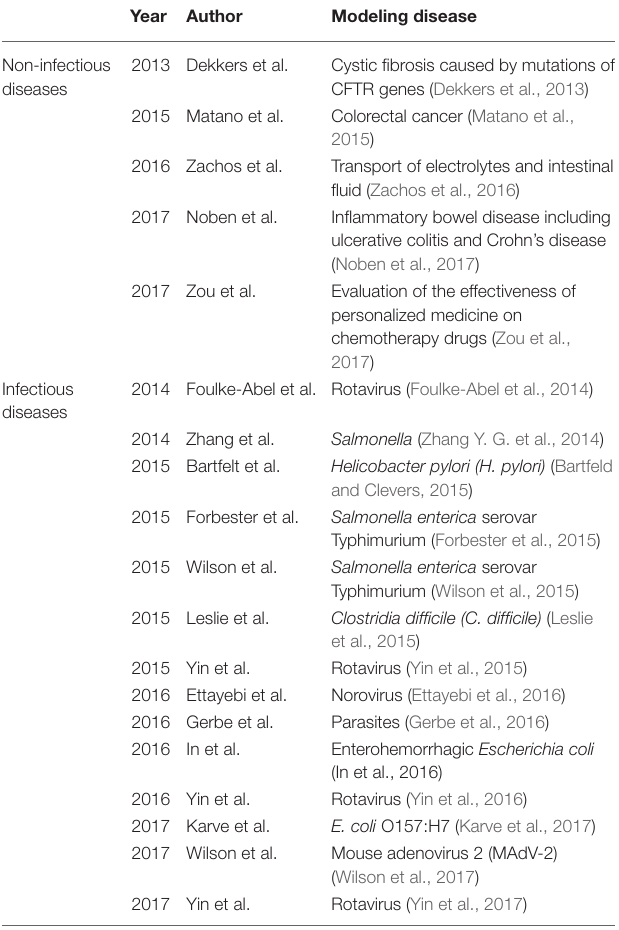
TABLE 2 | Various intestinal physiology and disease processes have been modeled by organoids and